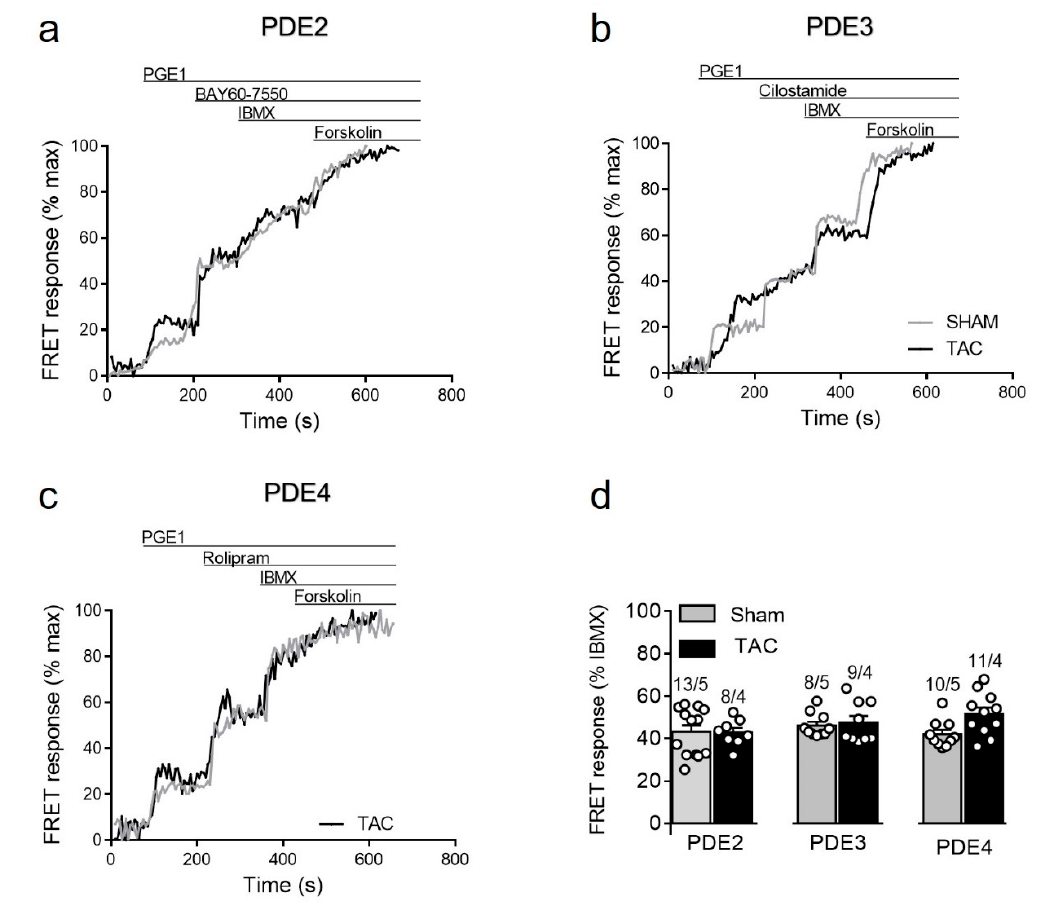
Figure 7. cAMP responses upon PDE inhibition after prostaglandin EP receptor stimulation in sham and TAC myocytes. Representative FRET ratio traces recorded from cells in response to EPR stimulation with 100 nmol/L of PGE1, followed by ( a ) 100 nmol/L of the PDE2 inhibitor BAY60-7550, ( b ) 10 µmol/L of the PDE3 inhibitor cilostamide, and ( c ) 10 µmol/L of the PDE4 inhibitor rolipram. PDE inhibitor responses were calculated as a% maximal PDE inhibition by 100 µmol/L IBMX). Forskolin (10 µmol/L) was applied at the end of each experiments to obtain the maximal FRET response. ( d ) Quantification of PDE inhibitor responses in sham and TAC myocytes. Means ± SE. Number of cells/mice are stated above the bars.